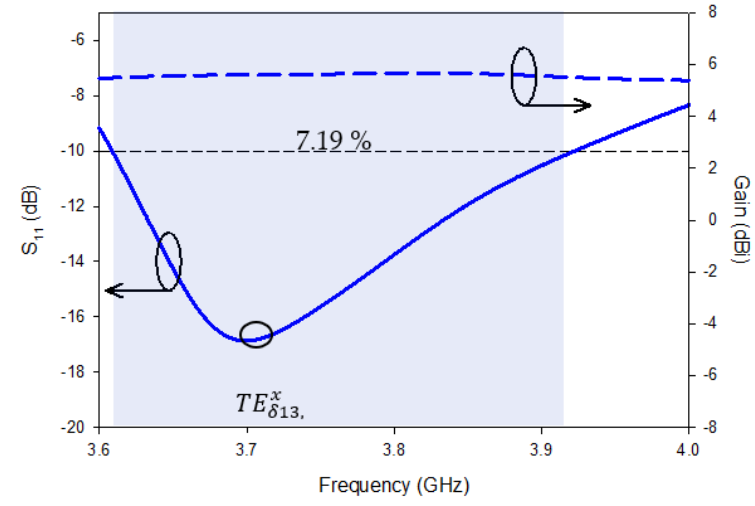
Figure 4. Simulated S 11 and gain of Design-1.